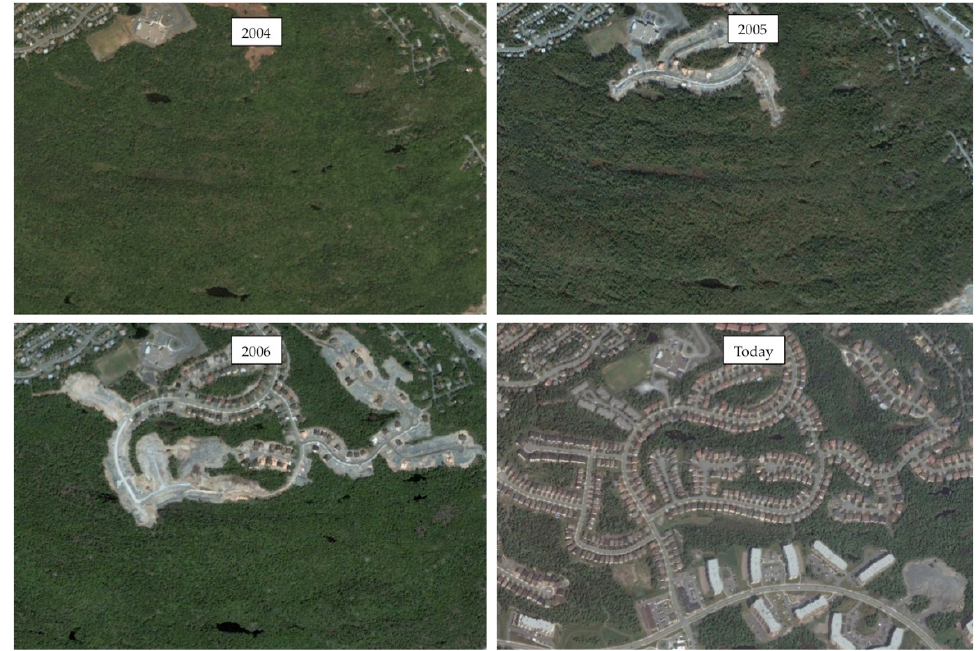
Figure 1. Aerial imagery showing the development of Stoney Creek (London, Ontario) from field to subdivision. Source: University of Western Ontario and Google Earth © DigitalGlobe.